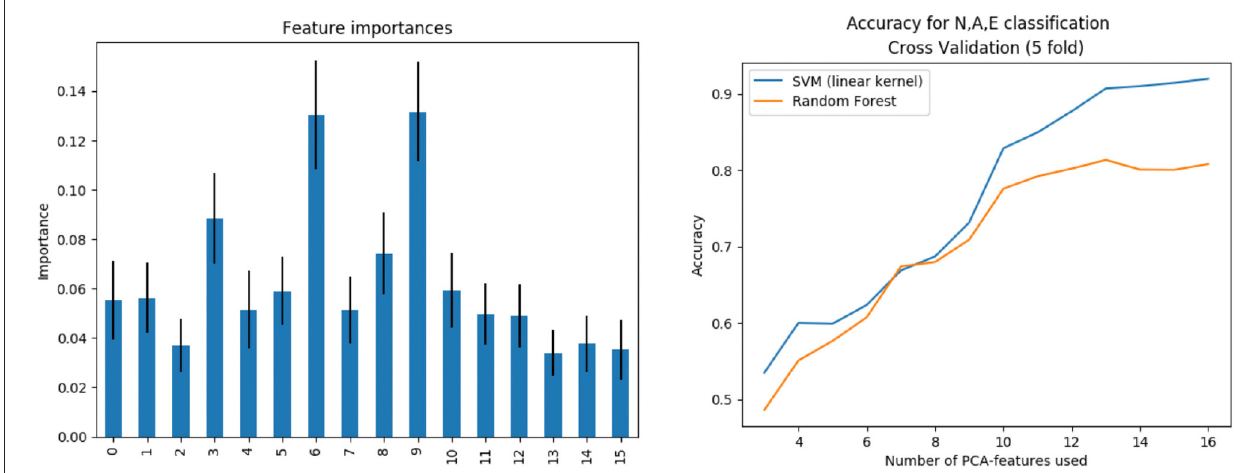
FIGURE 10 | Left: Features importance. Right: Subpopulation classification accuracy as the number of features increases.